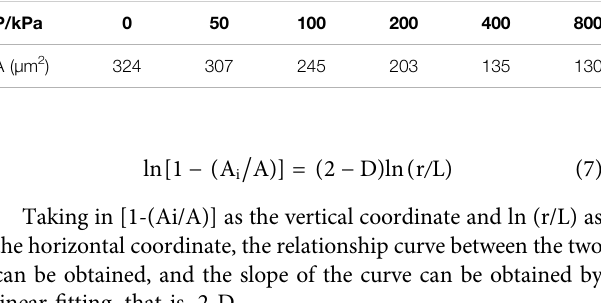
TABLE 2 | Area of calcium carbonate in soil cross-section, ×1,600.